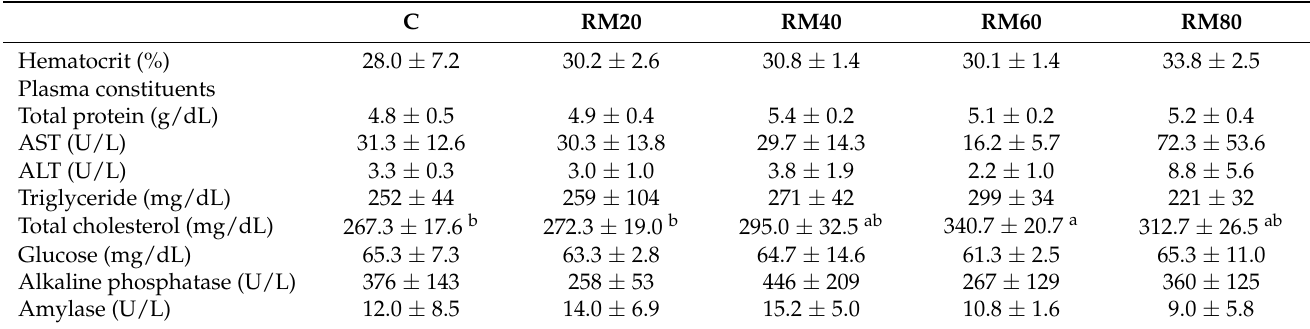
Table 9. Hematocrit levels and plasma constituents in fish under Trial 1.